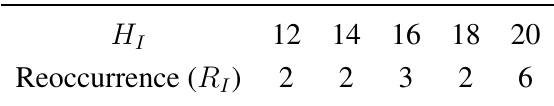
Table 3. Recurrences of unique Hamming distance values.